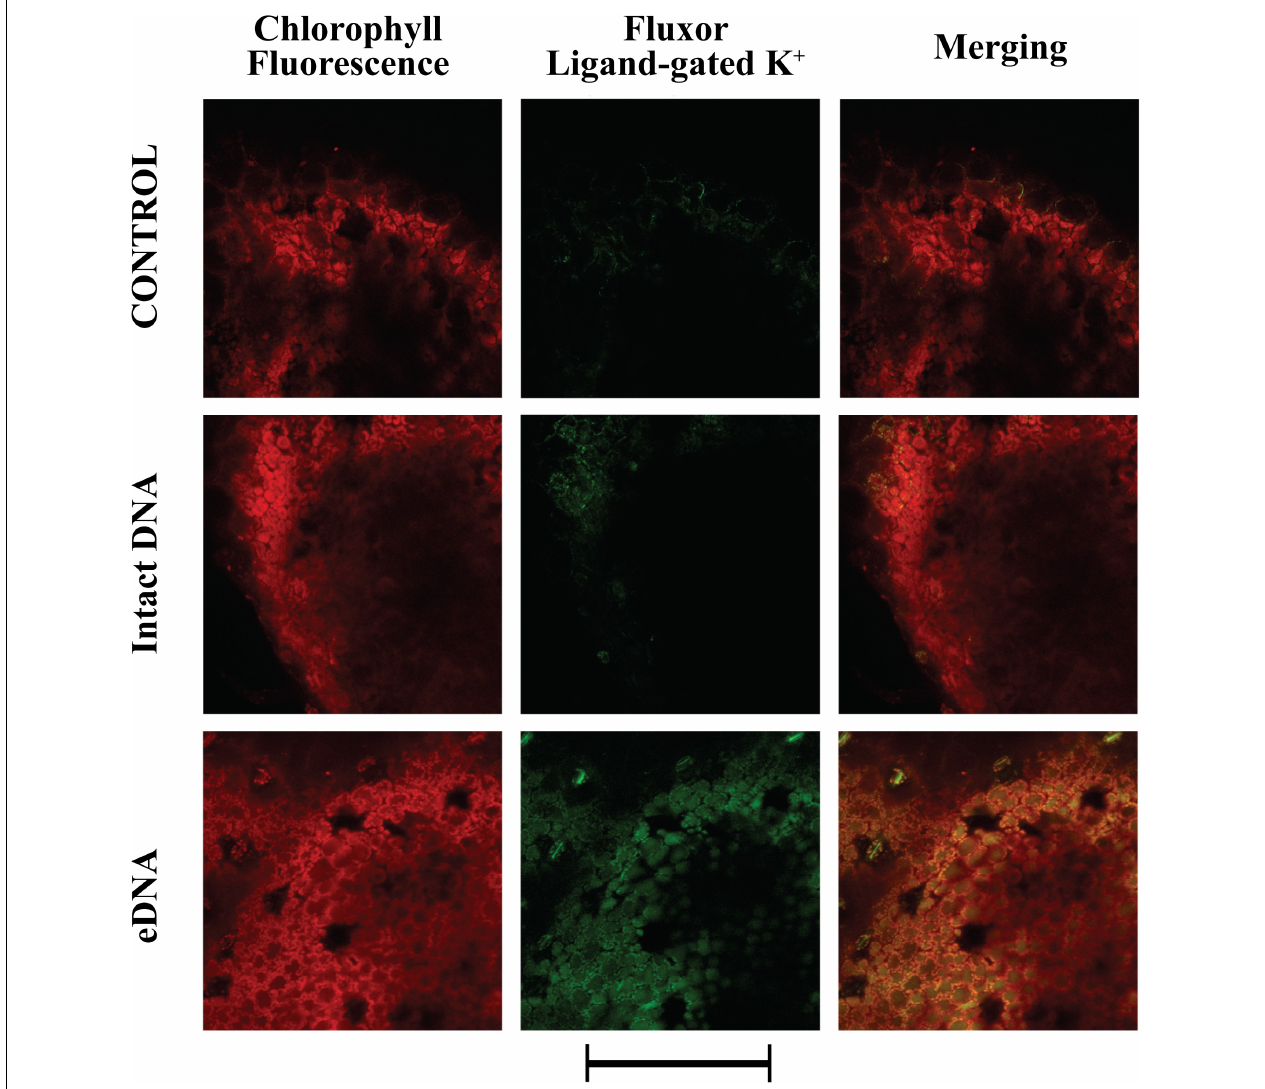
FIGURE 4 | Intracellular potassium ligand-gated variations in tomato leaves in controls (no treatment) and upon treatments with tomato intact DNA and eDNA. False-color image analysis reconstructions from confocal laser-scanning microscope observations, and fluorochemical evidence of ligand-gated K + channel activity. Fifty microliters of 200 µ g ml − 1 of either eDNA or intact DNA were applied and after 50 min the K + signature was observed. Pictures represent portions of the tomato leaf blade where the green fluorescence refers to FluxOR TM associated to ligand-gated K + channel activity, whereas the chloroplasts are evidenced by a bright red color caused by chlorophyll fluorescence. Scale bar (250 µ m) is indicated at the bottom of the figure. Pictures are the results of the merging of 25 individual optical